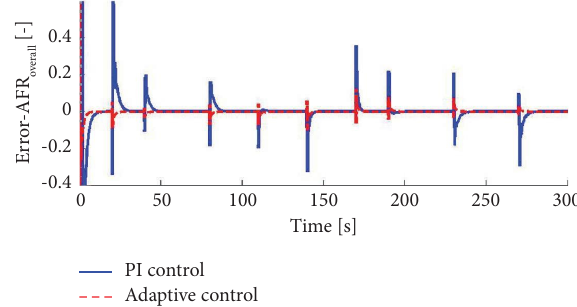
Figure 7: Overall AFR control error for the hydrogen-enriched E10 blend.